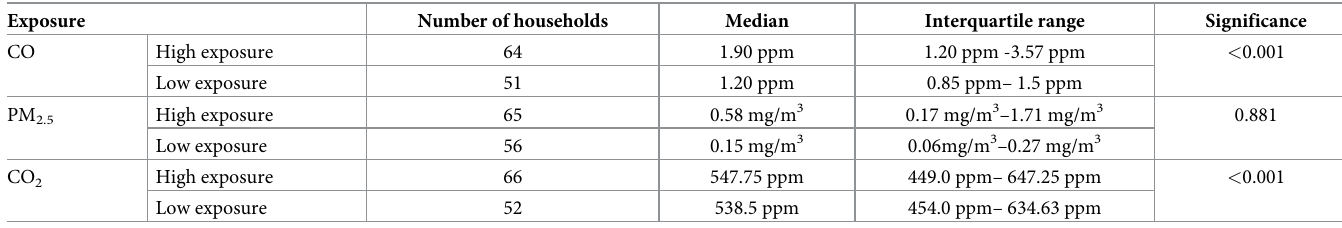
Table 5. Air quality measurements in selected